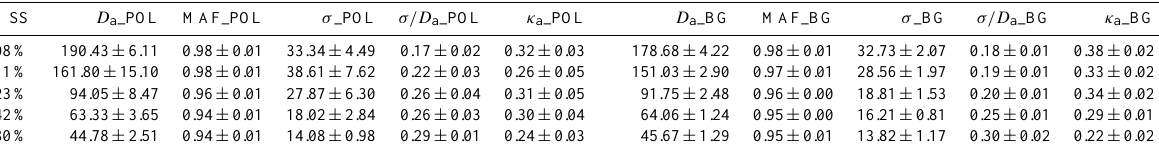
Table 1. Parameters describing the CCN efficiency spectra and hygroscopicity for polluted (_POL) and background (_BG) cases: the activa- tion diameter ( D a ) , the maximum activated fraction (MAF), the CDF standard deviation ( σ) , the heterogeneity parameter ( σ/D a ) , and the hygroscopicity parameter ( κ a ) values shown are arithmetic mean values with one standard deviation averaged over the entire measurement period.